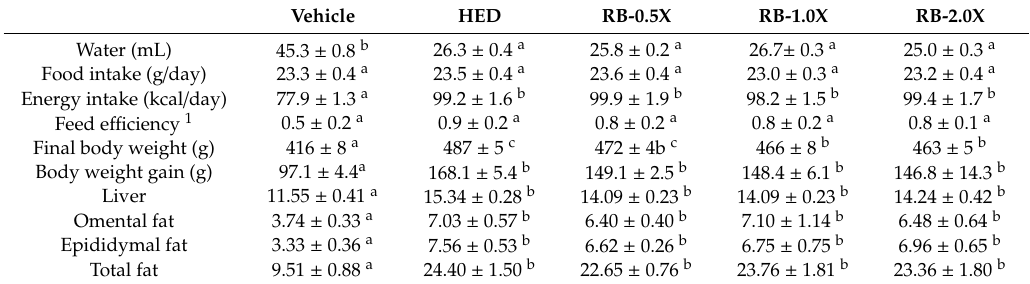
Table 1. Comparison of the physical and metabolic e ff ects of rice bran (RB) in rat